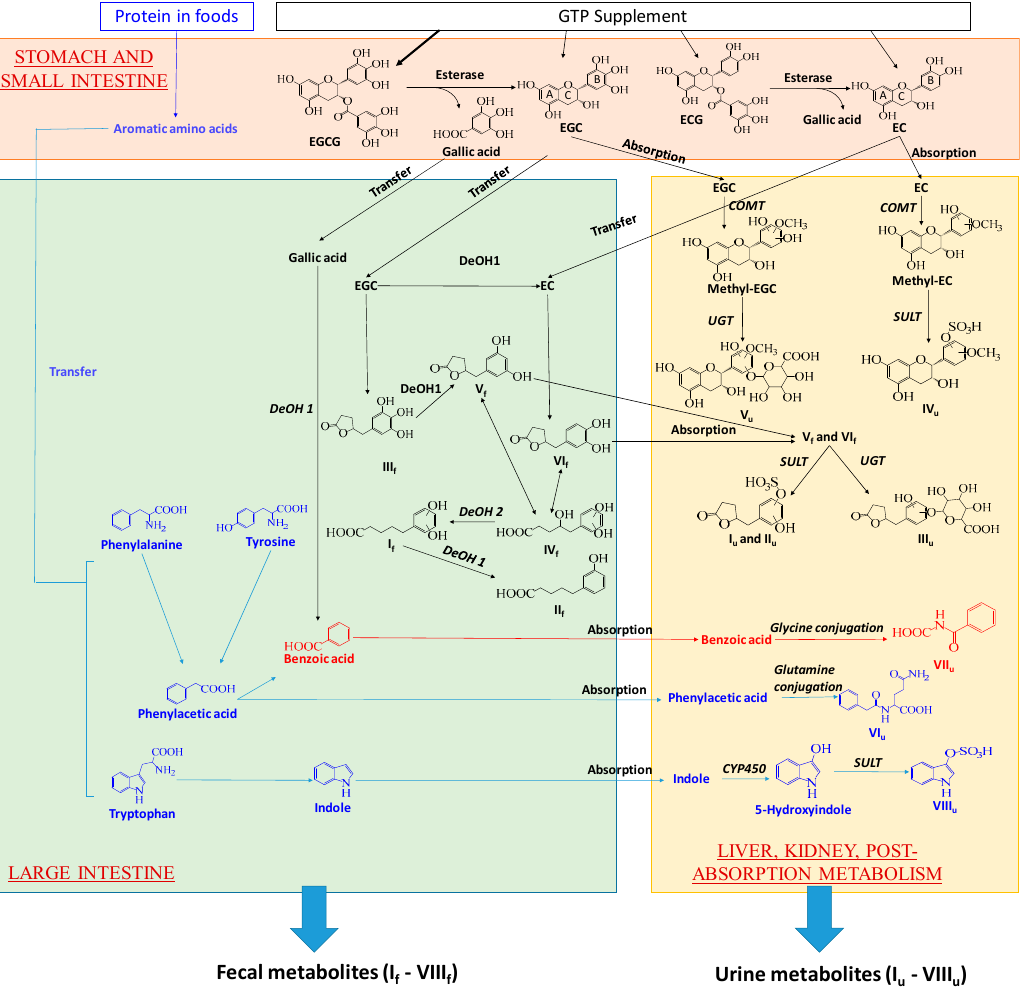
Figure7. ProposedmajormetabolicpathwaysforformingGTP-derivedmetabolitesandGTP-responsive Figure 7. Proposed major metabolic pathways for forming GTP-derived metabolites and GTP- metabolites in feces and urine by gut microbiota and human metabolism system. Metabolic pathways responsive metabolites in feces and urine by gut microbiota and human metabolism system. shared by GTP and AAA are in red. DeOH: Metabolic pathways shared by GTP and AAA are in red. DeOH: dehydroxylation.